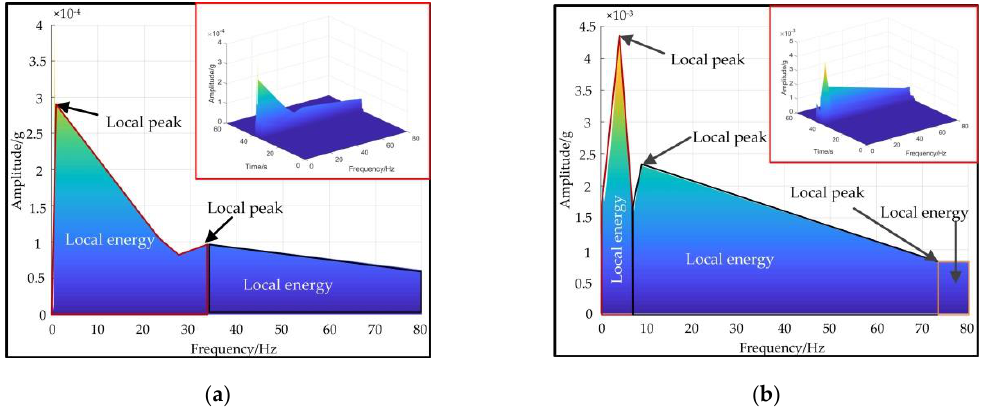
Figure 19. ( a ) Front view of the time – frequency spectrum (sensor No. 3, Segment 1). ( b ) Front view of the time – frequency spectrum (sensor No. 3, Segment 2). Table 7. Local peak and energy in different frequency bands and maximum local peaks and energies.